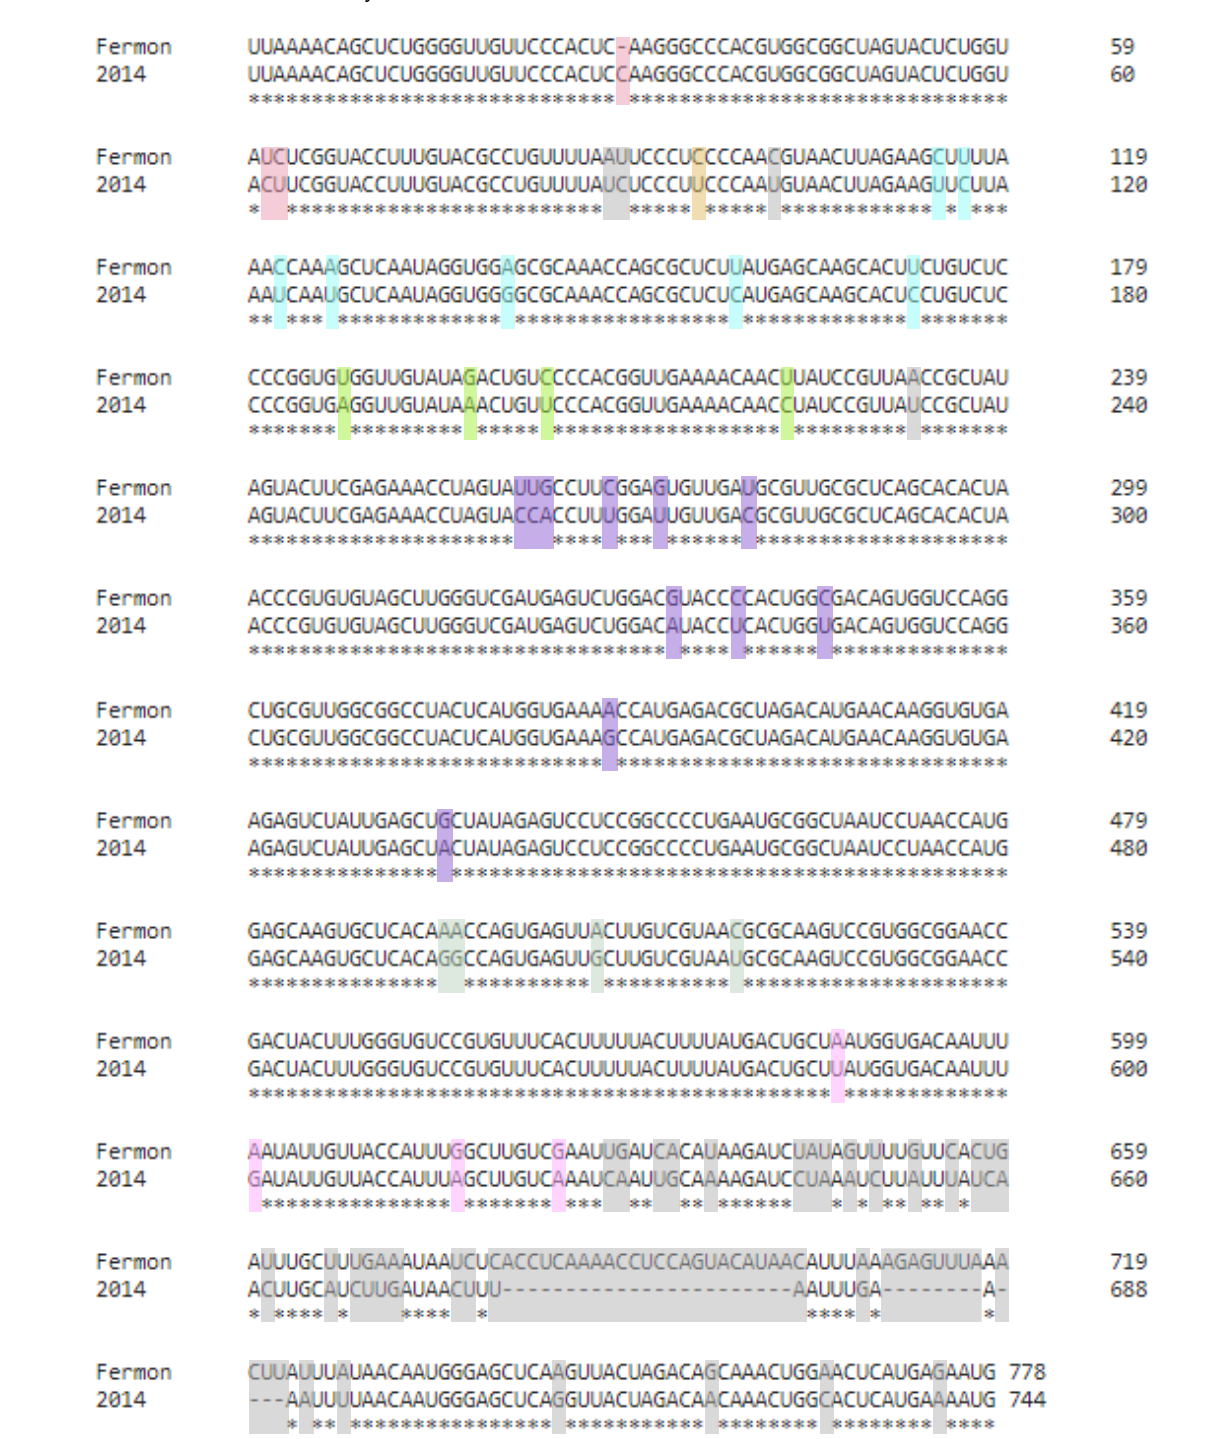
Figure 1. Multiple sequence alignment (MSA) of EV-D68 5 ′ UTRs. The sequence alignment shows base substitutions, insertions and deletions in the 2014 strain as compared to the original Fermon isolate. The MSA was generated using Clustal Omega. Using the Fermon strain as a reference, nucleotide alterations are colored based on the 5 ′ UTR domain: domain I = red, domain II = light blue, domain III = light green, domain IV = purple, domain V = sage green, domain VI = pink, and long-range interaction (LR) =